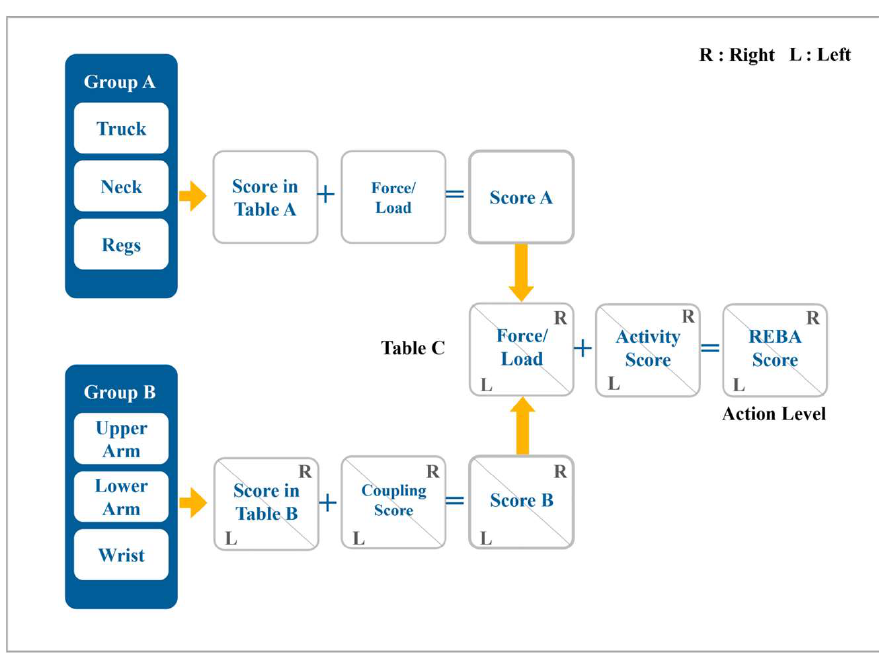
Figure 17. REBA evaluation procedure.